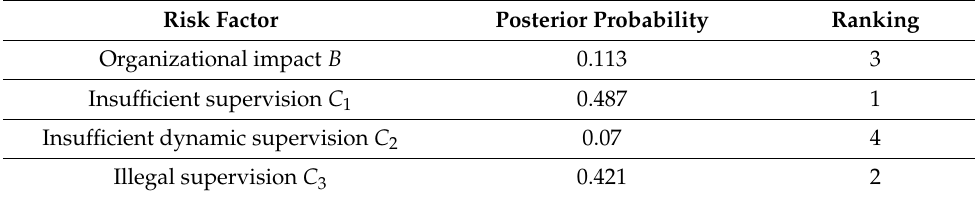
Table 7. Posterior probability of reasoning on node